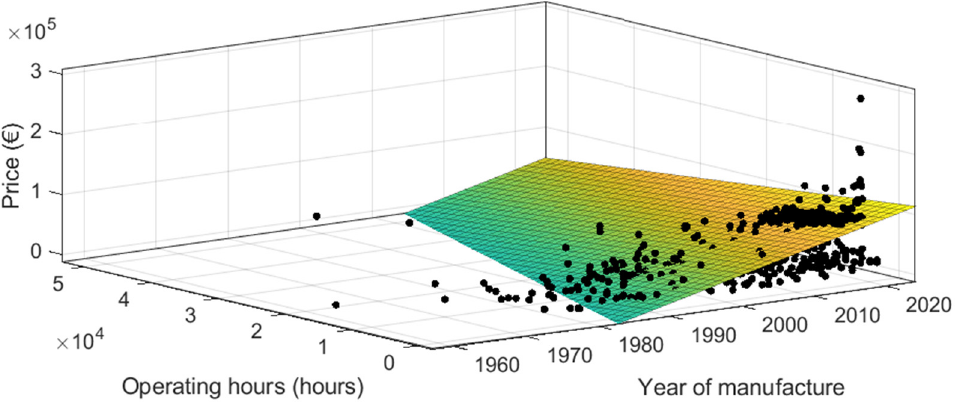
Figure 22. Price vs. power and year of manufacture for second-hand tractors.